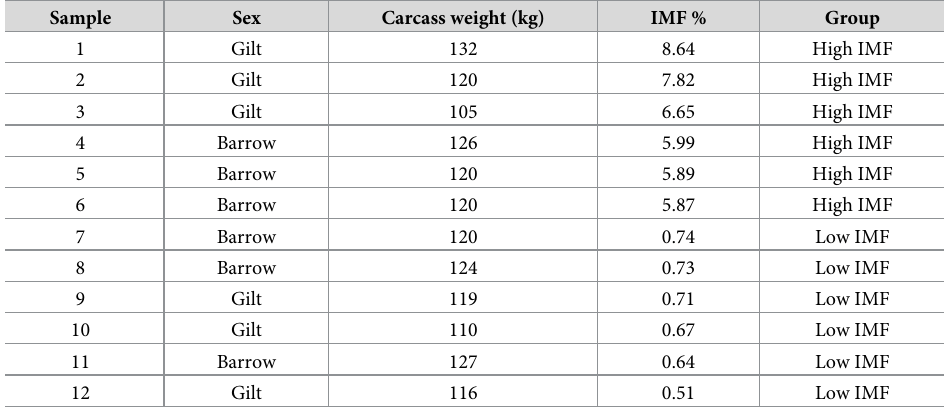
Table 1. Sex, intramuscular fat (IMF) % and group membership of the used pig samples. Sample